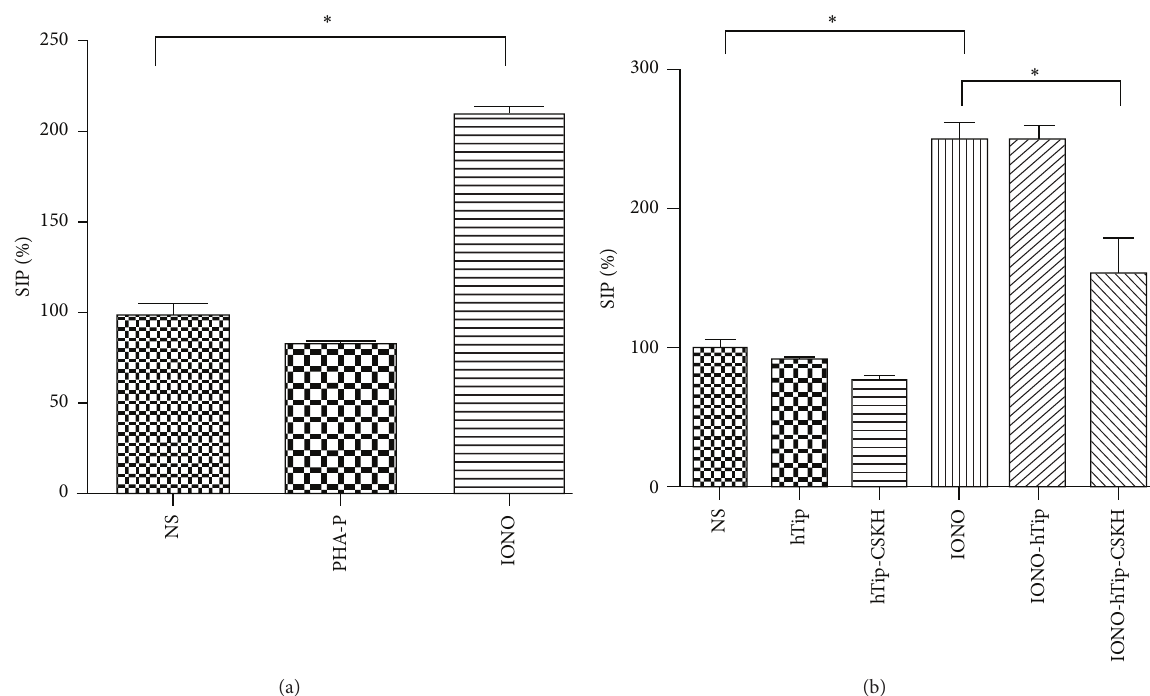
Figure 4: hTip-CSKH induced a decreased cell proliferation in Jurkat cells. (a) Jurkat cells were treated with PHA-P or ionomycin and assayed for [ 3H ] -thymidine incorporation after 48-hour treatment. (b) Jurkat cells were treated with hTip, hTip-CSKH for 1h, and then ionomycin- stimulated and assayed for [ 3H ] -thymidine incorporation. Jurkat cells treated with each peptide alone or nontreated peptides were added as controls. Stimulation index percentage (SIP) is shown (see Section 2). NS: nonstimulated; Iono: ionomycin. Student’s 𝑡 -test statistically significant values ( 𝑝 < 0.05 ) are marked with asterisk ( ∗